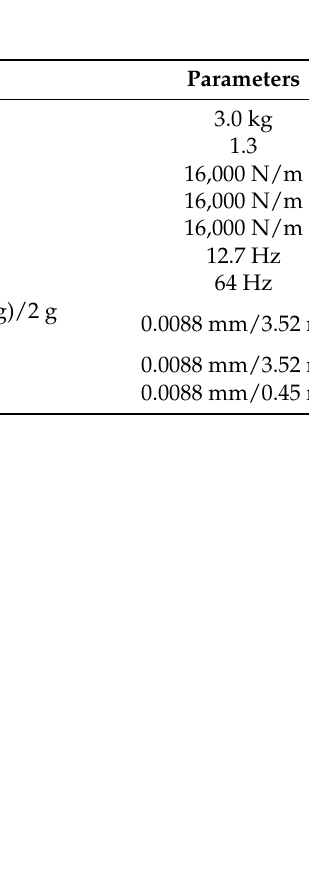
Figure 2. The physical model of the linear single-degree-of-freedom spring and damper system. Table 2. The compressor isolation system parameters.